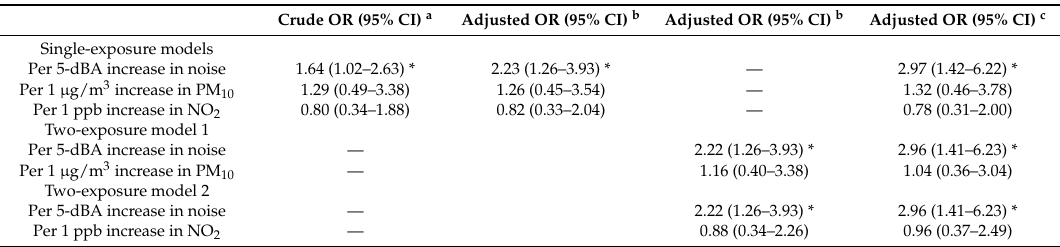
Table 6. Associations between continuous exposure of noise and air pollutants and the prevalence of cardiovascular